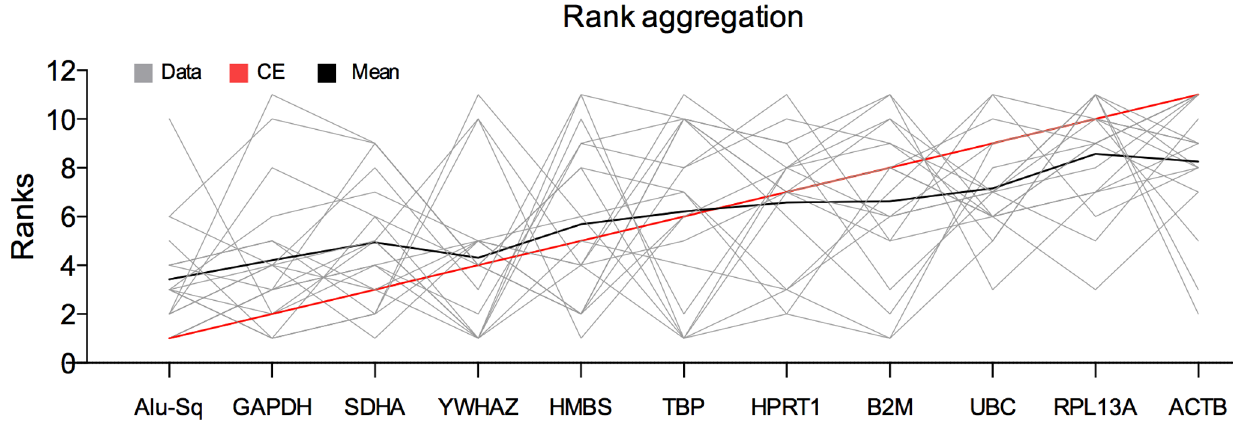
Figure 4. Rank aggregation analysis. Rank aggregation result using the cross entropy algorithm with spearman’s foot-rule weighted distance which shows a consensus order of reference genes from the most stable to the least stable.